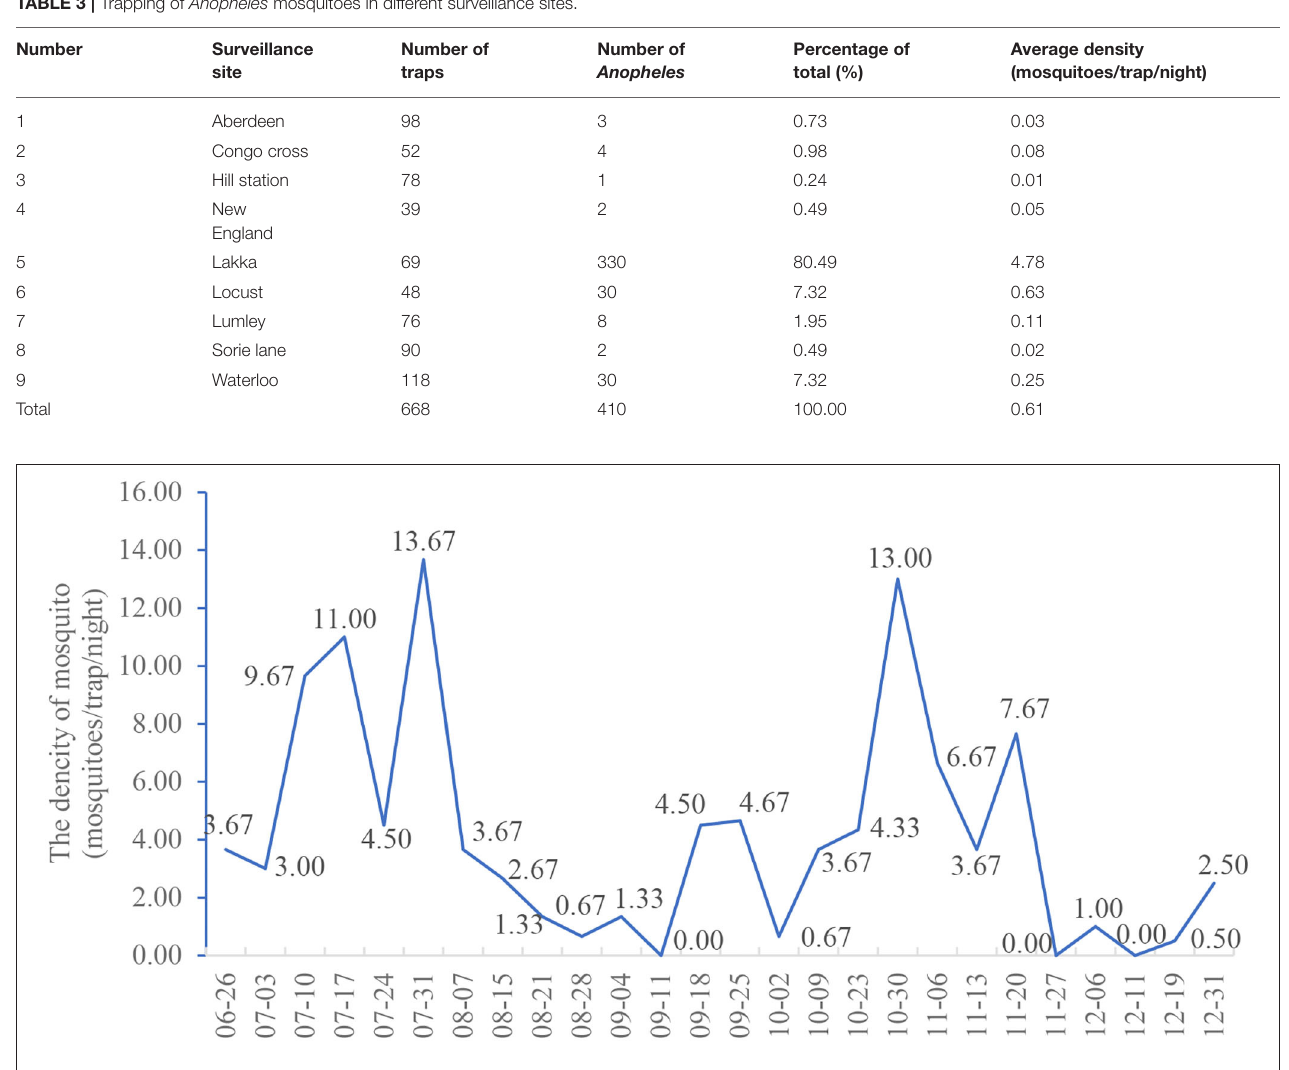
all heterozygous resistant to the kdr L1014F mutation (100%) ( Table 4 ). Some samples were confirmed by another test